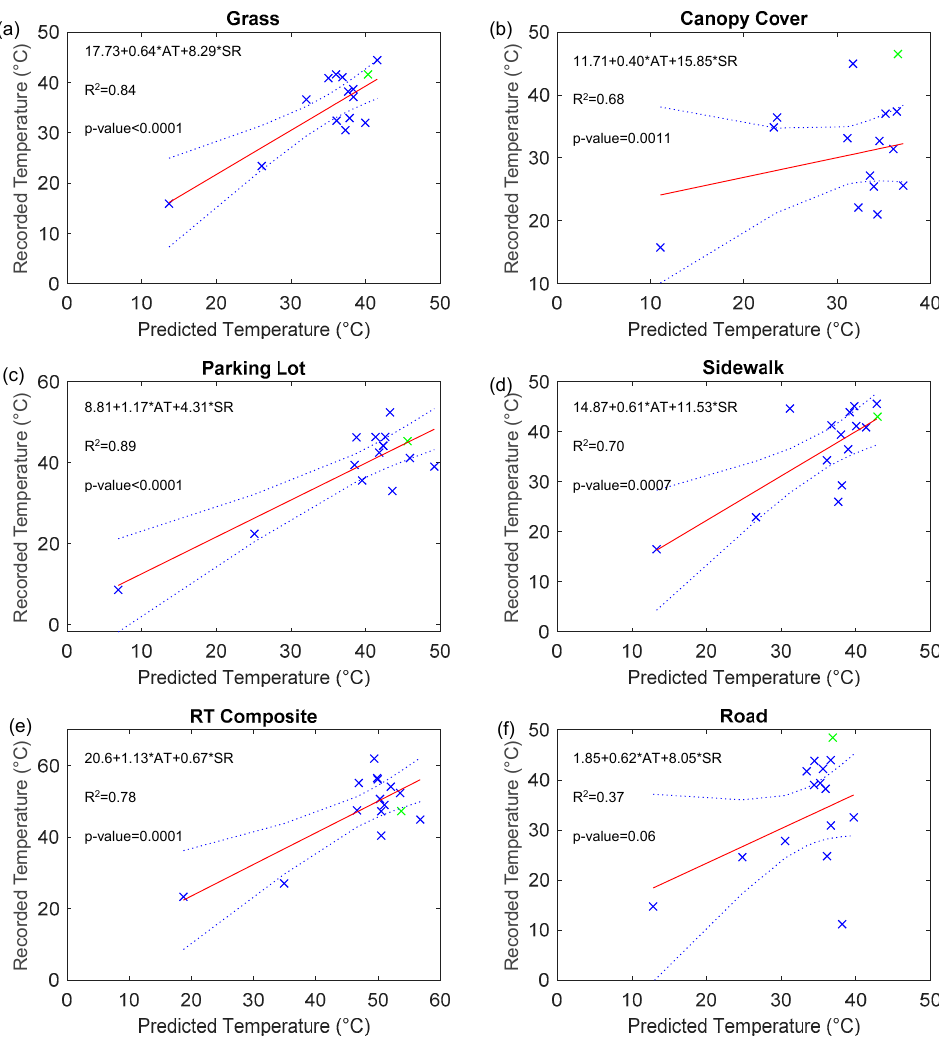
Figure 9. Temperature prediction models of six surface types: grass ( a ), canopy cover ( b ), parking lot ( c ), sidewalk ( d ), composite rooftop ( e ) and road ( f ). UTEP datapoint is fitted in green. Note the 95% confidence intervals are in blue.